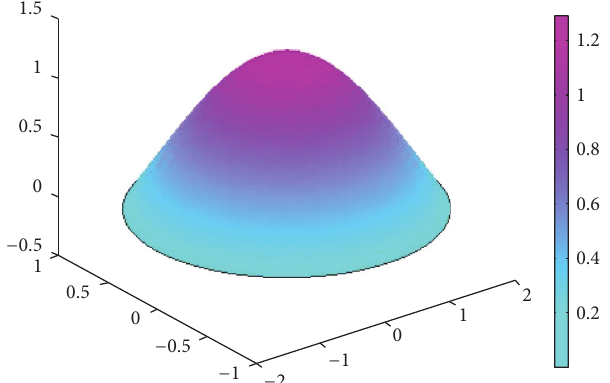
Figure 4: Stress function Ψ 1 ; 𝑎 = 2 , 𝑏 = 1 ; 𝑘 1 = 𝑘 3 = 1 , 𝑘 2 = 𝑐 = 2 . Color spectrum: Ψ 1 .